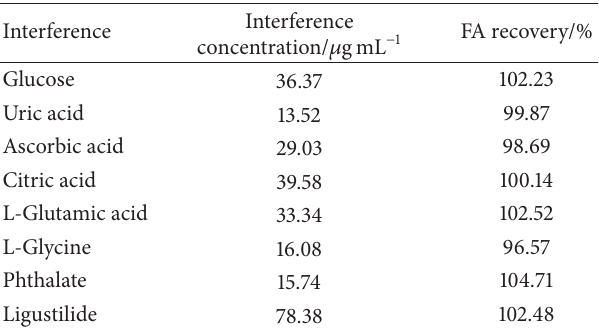
Figure 8: The plots of the anodic peak currents against the volume of modification. Table 1: Interference of different species in the determination of FA at